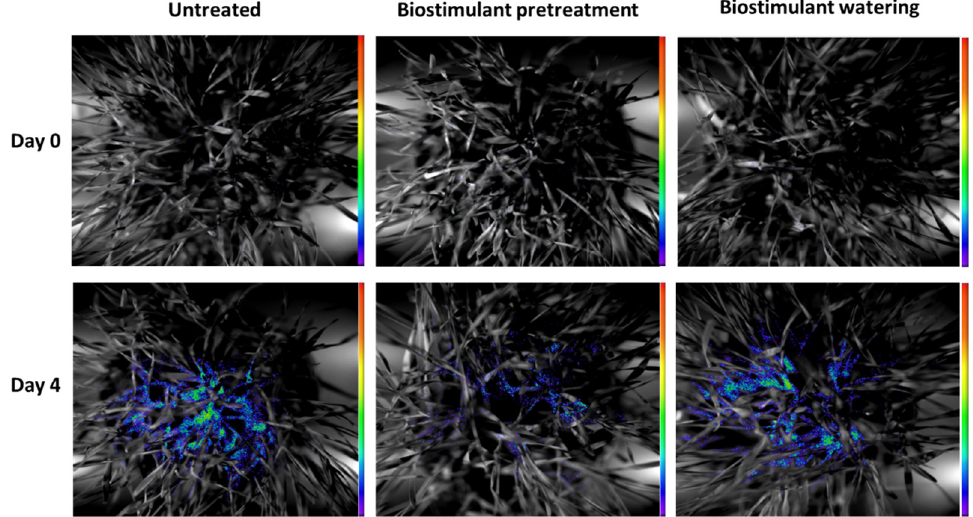
Figure 3. Images of the biophoton emission signals of 15-day-old heat-stressed wheat seedlings on day 0, as the starting point of HS, and on day 4. The intensity color bar shows signal intensity detected by the equipment and converted into a scale of pseudocolor intensity via the software.